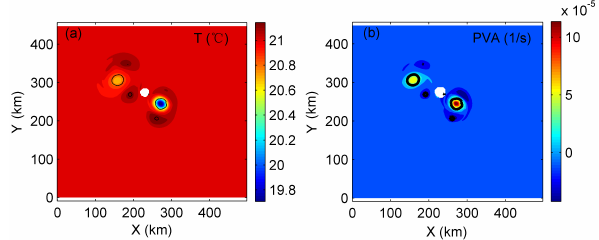
Figure 6. The cold eddy splits into two eddies during the interac- tion with an island of 20km in diameter on day 50 (the temperature (a) and potential vorticity anomaly, PVA, (b) shown are at 100m depth). The black solid lines are the O – W parameter with a value of − 0.2 σ w